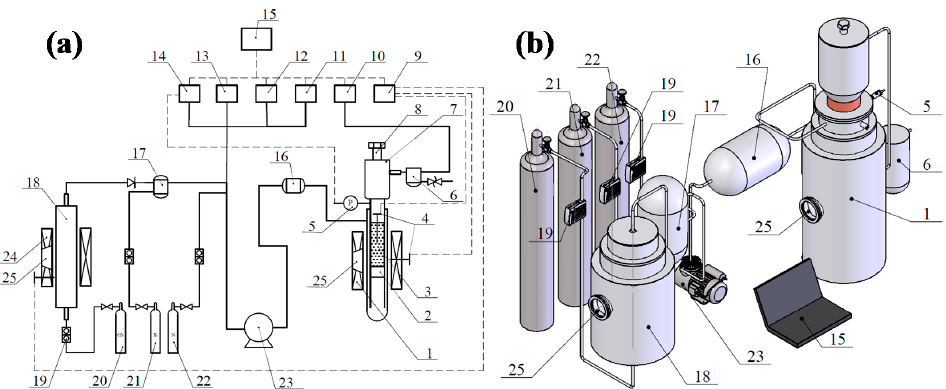
Figure 2. Experimental setup: ( a ) flow chart; ( b ) fluidized bed reactor. 1. Gas mixing and preheating